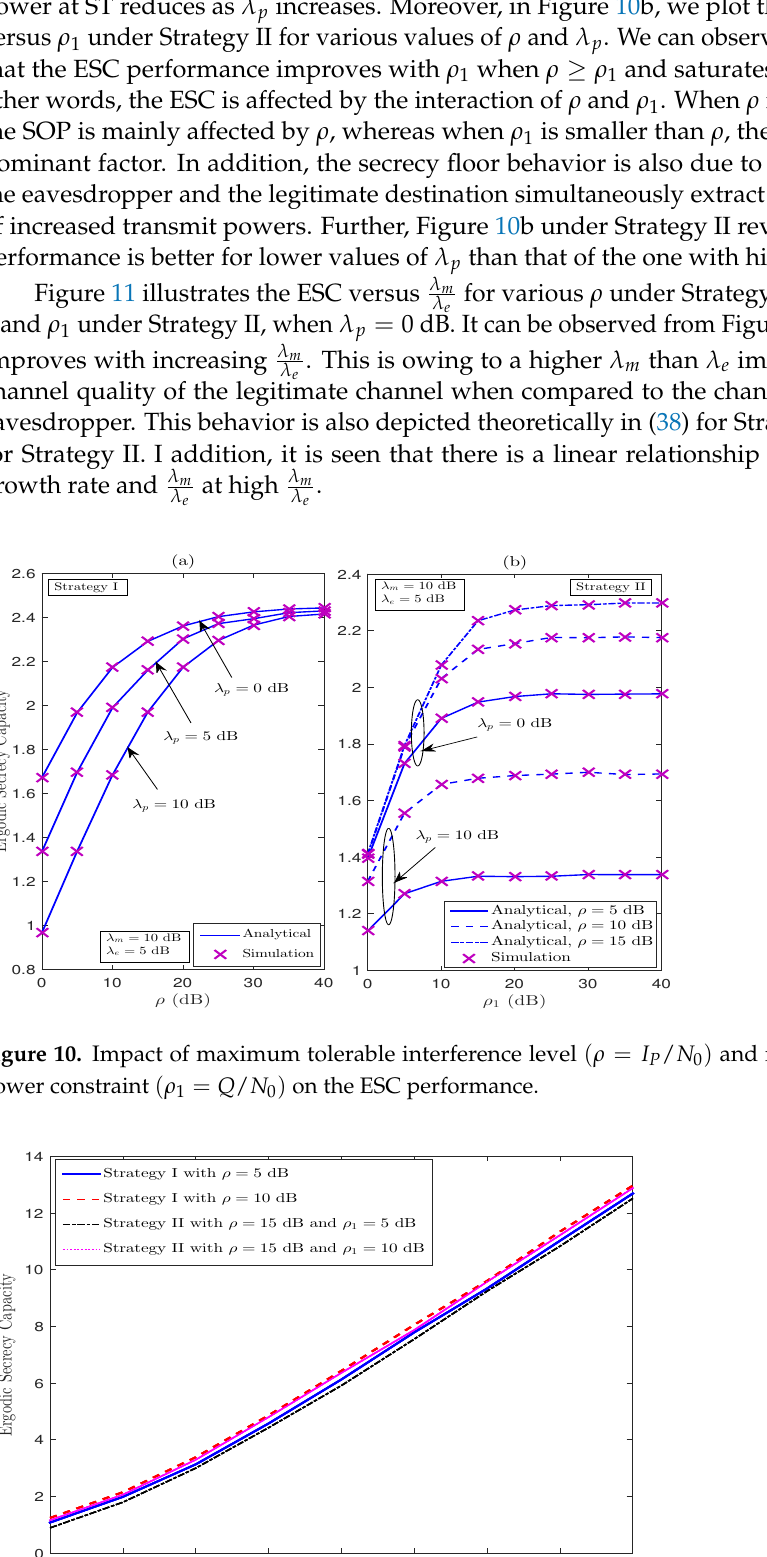
under Strategy I and Strategy λ e